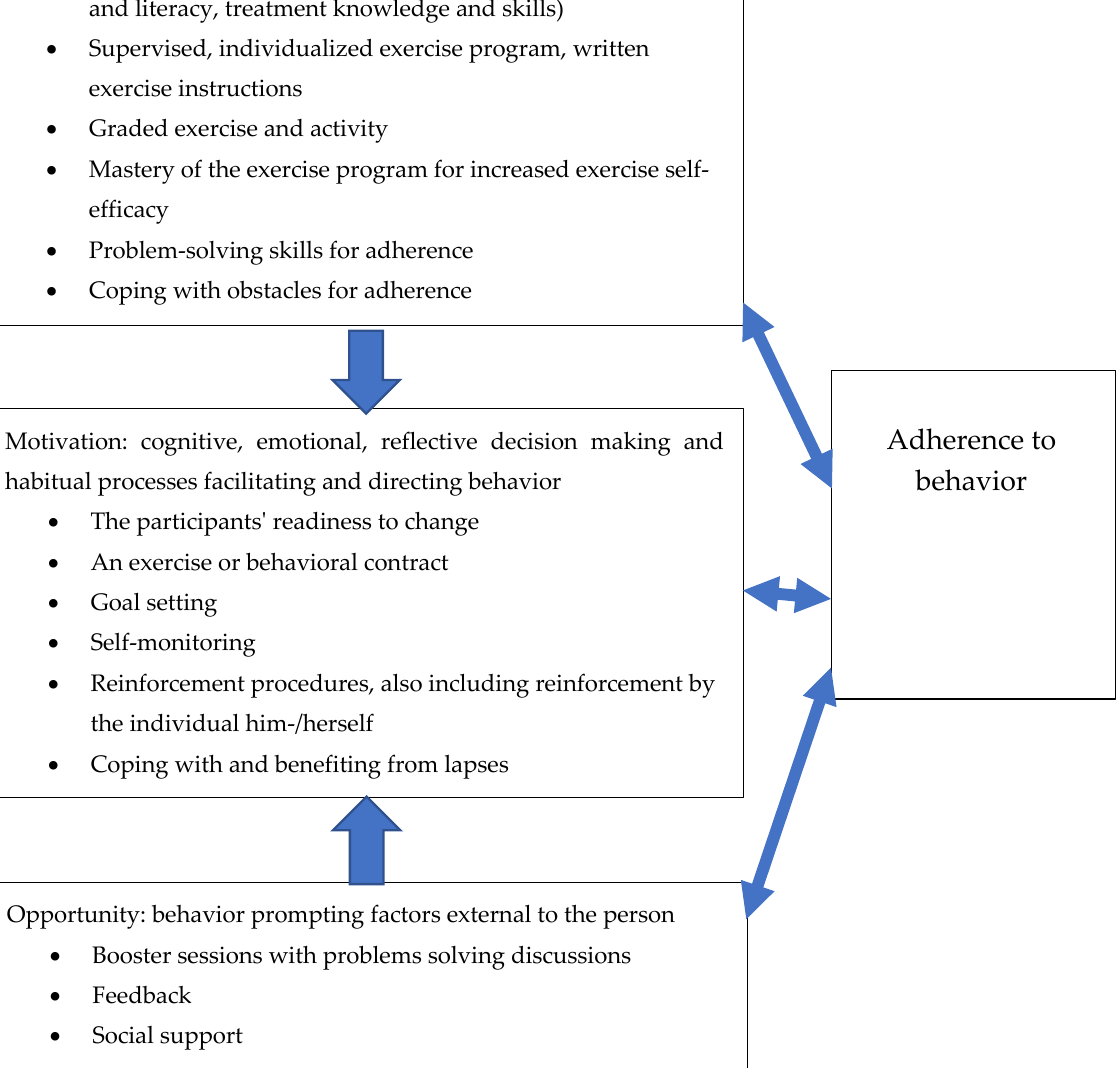
Figure 3. Model for adherence to a behaviour, inspired by [42]. The components were retrieved from previous studies on adherence to pain-related exercise programmes targeting participants mostly <65 years of